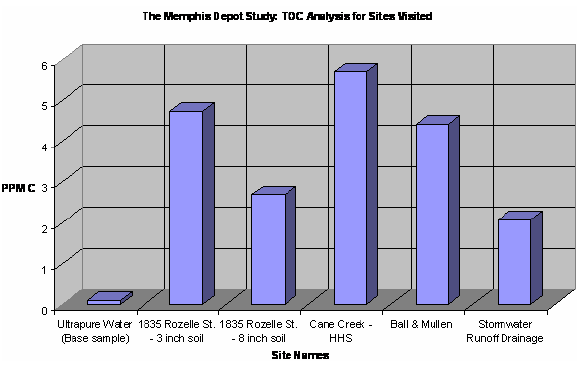
Figure 4: Total Organic Carbon (TOC) Results